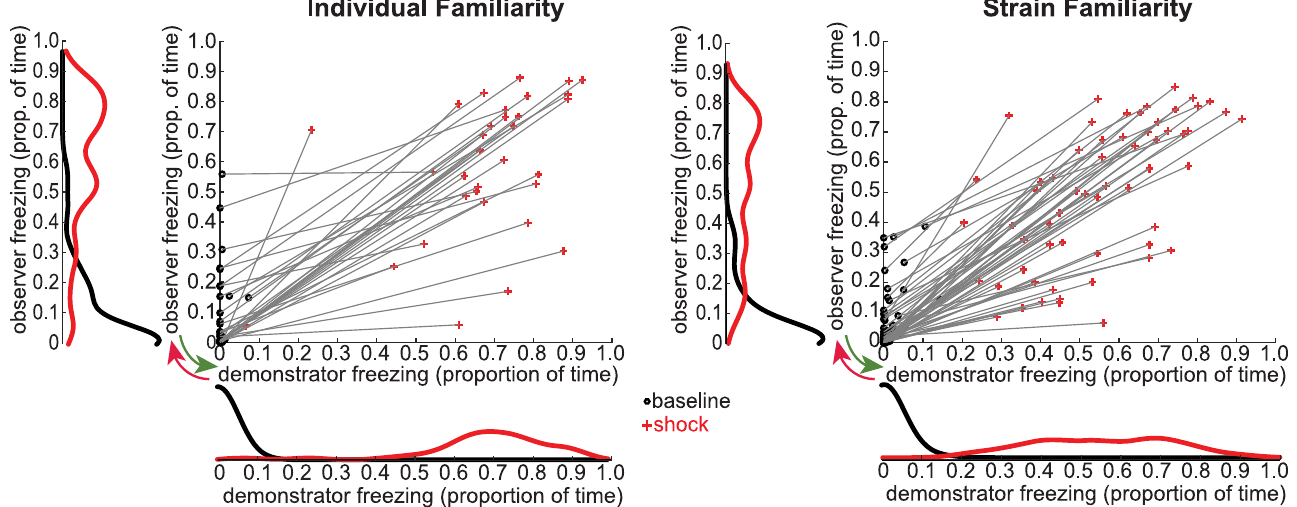
Fig 3. Observer and demonstrator freezing. For both the individual familiarity and the strain familiarity experiments, the scatter plots indicate the prop. of time spent freezing by the demonstrator (x-axis) and observer (y-axis) during both baseline (black dots) and the shock period (red pluses). The marginal histograms indicate the distribution of freezing behavior during baseline (black lines) and the shock period (red lines) using a kernel with 0.05 bandwidth. Red arrow: possible influence of the demonstrator freezing on the observer freezing (akin to emotional contagion). Green arrow: possible influence of the observer freezing on the demonstrator freezing (akin to social buffering if the level of the observer freezing is lower than that of the demonstrator). Data can be found at http://dx. doi.org/10.17632/h8fkyr2z35.1. prop., proportion.